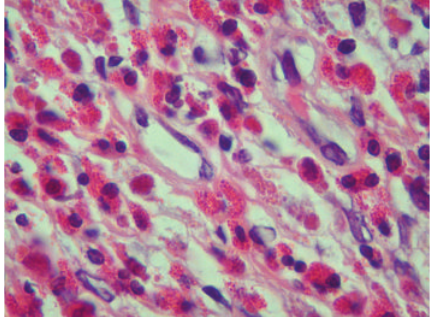
Figure 5: This high-power oil immersion view of the serosa shows sheets of eosinophils with abundant eosinophilic granules (H&E stain; magnification 1000 ×